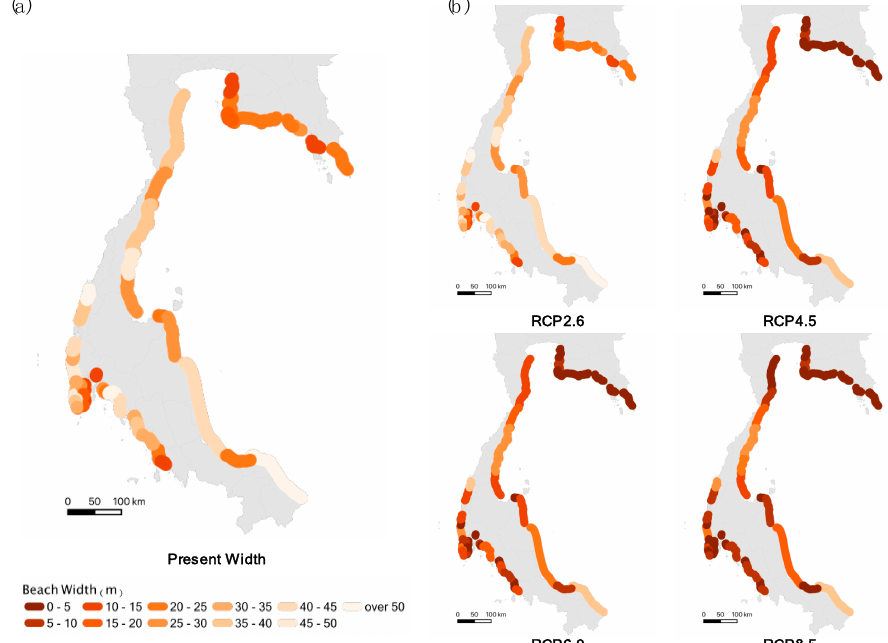
Figure 2. Beach width at ( a ) the present condition ( b ) the Future (2080–2100) projections based on 4 RCP scenarios adapted from the results of beach loss projection due to SLR by Ritphring et al. study [10] in which the calculation was based on the Bruun rule assumption.